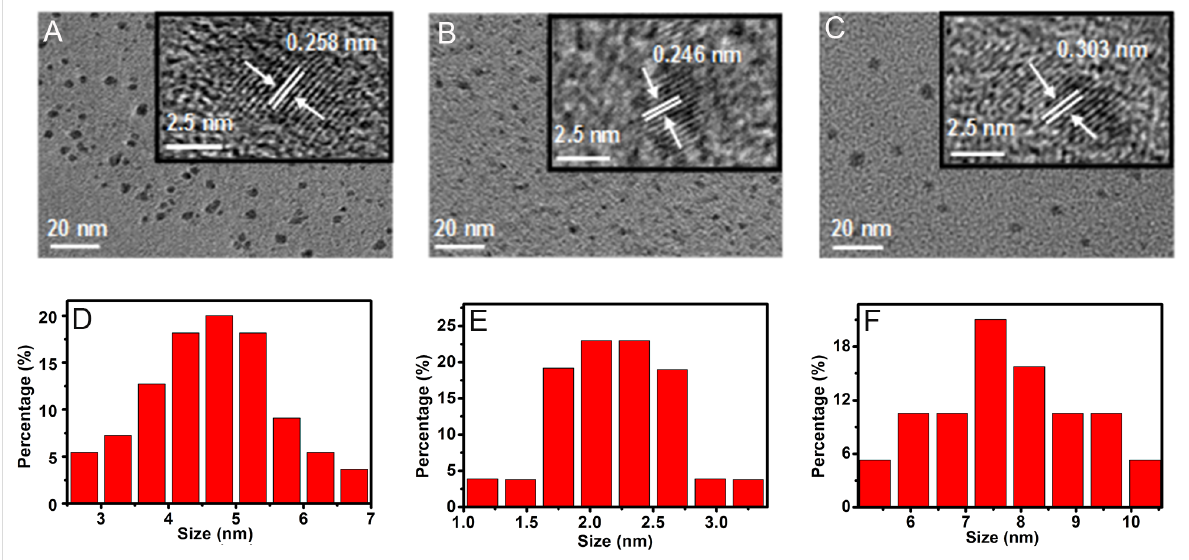
Figure 1: TEM and HRTEM (inset) images of (A) S a , (B) S b , (C) S e samples, and corresponding size (diameter) distribution ranges for (D) S a , (E) S b , and (F) S e.